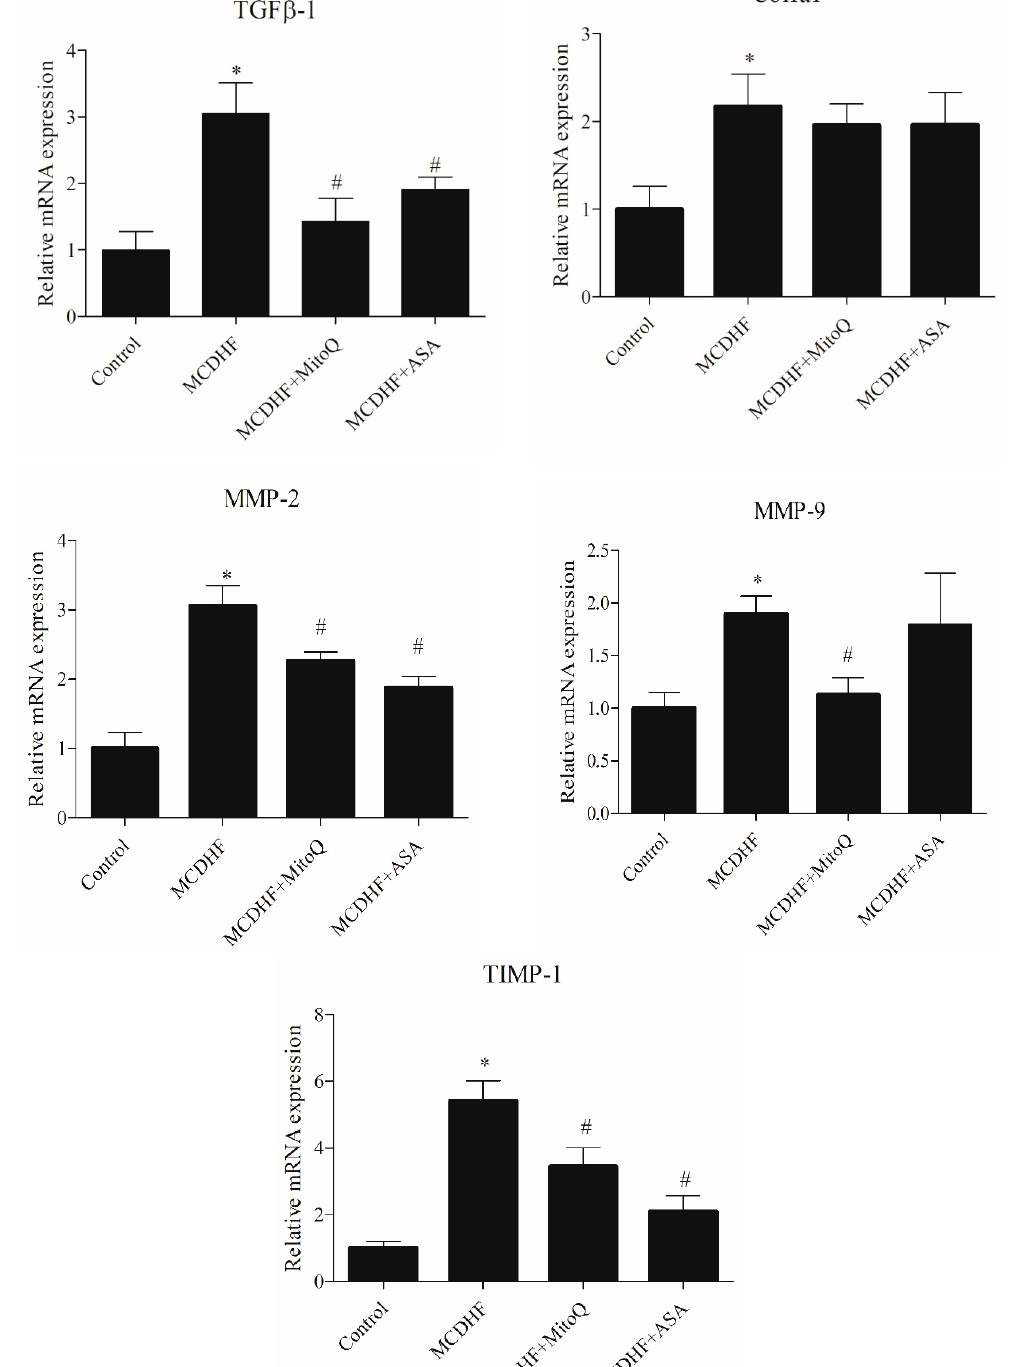
Figure 4. mRNA expression of Col1a1, TGF β -1, MMP-2, MMP-9, and TIMP-1 in livers from control, MCDHF, MCDHF + MitoQ, and MCDHF + ASA mice. * p < 0.05 vs. control; # p < 0.05 vs. MCDHF. In MCDHFD mice, expression of genes associated with liver fibrosis, i.e., Col1a1, TGF β -1, TIMP-1, MMP-2, and MMP-9, was significantly higher than in controls; treatment with MitoQ decreased the expression of TGF β -1, TIMP-1, MMP-2, and MMP-9, while treatment with ASA decreased the expression of TGF β -1, TIMP-1, and MMP-2. 3.3. Effects of ASA and MitoQ on Protein Expression of SOD-1, GPx-1, IL-10, and COX-2 in Liver In liver from MCDHFD mice, GPx-1, SOD-1, and IL-10 expression was impaired compared to control animals. In MCDHFD mice, MitoQ increased the expression of GPx-1 ( p < 0.05), while ASA increased the expression of both GPx-1 and SOD-1. In MCDHFD animals treated with both MitoQ and ASA, an increase in IL-10 protein ex- pression was also observed. In MCDHFD mice, COX-2 expression was increased com- pared to controls, but it was reduced in animals treated with MitoQ or ASA (Figure 5).